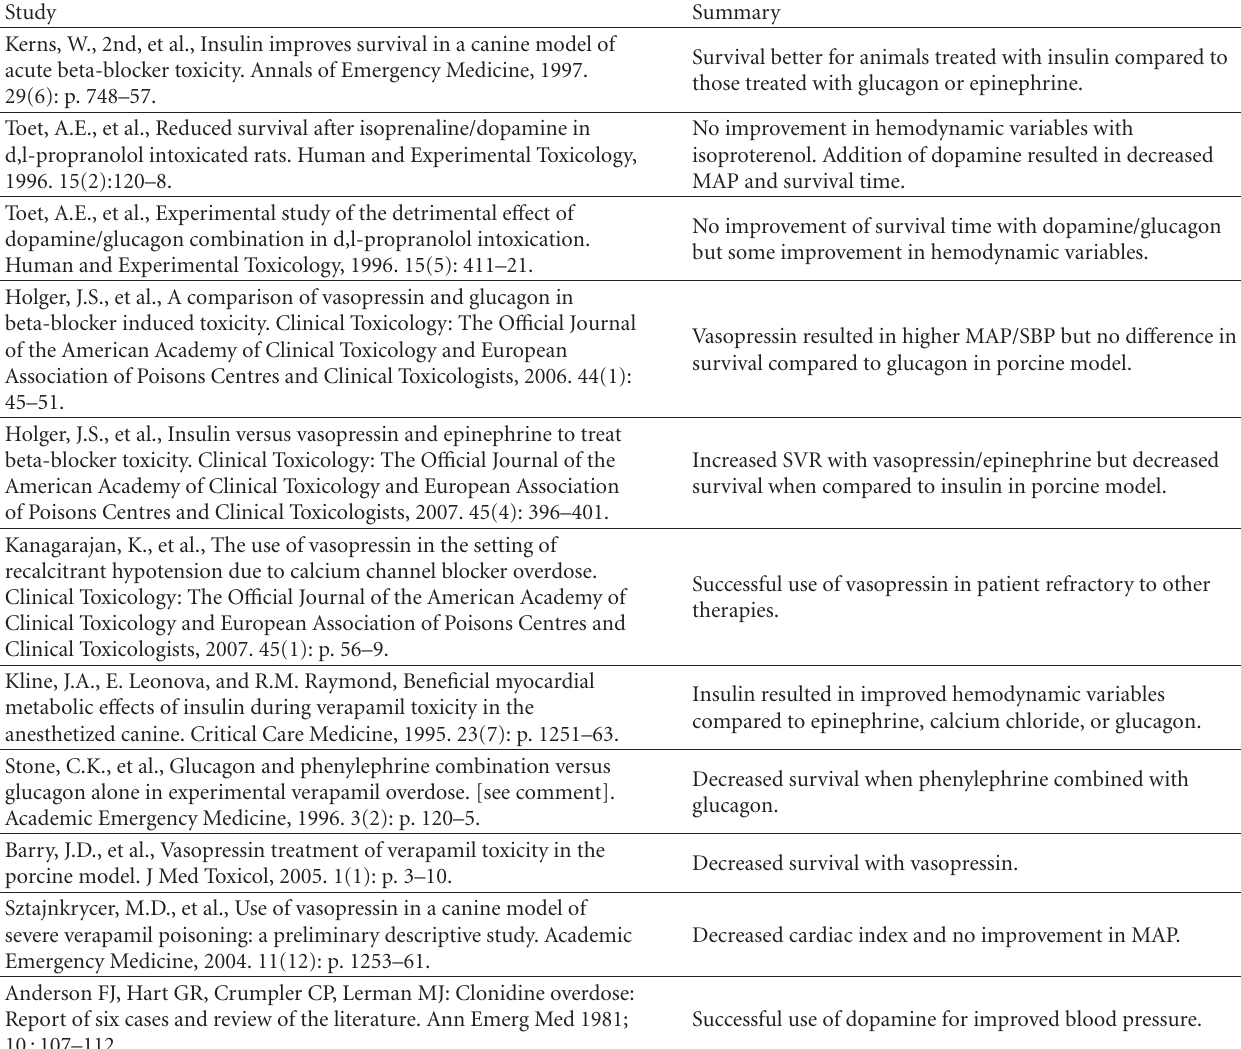
Table 2: Literature on vasopressor use in toxic